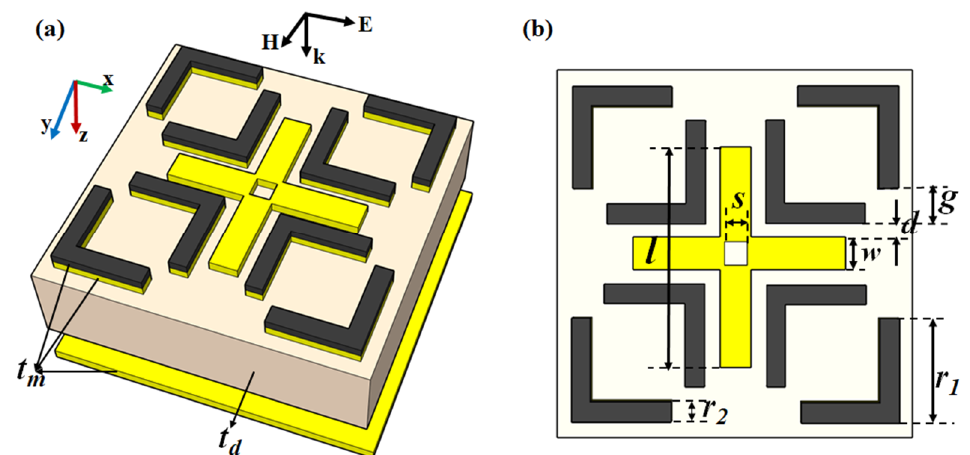
Figure 5. Unit-cell configuration of the graphene-integrated plasmonic MA in ( a ) perspective and ( b ) top views.